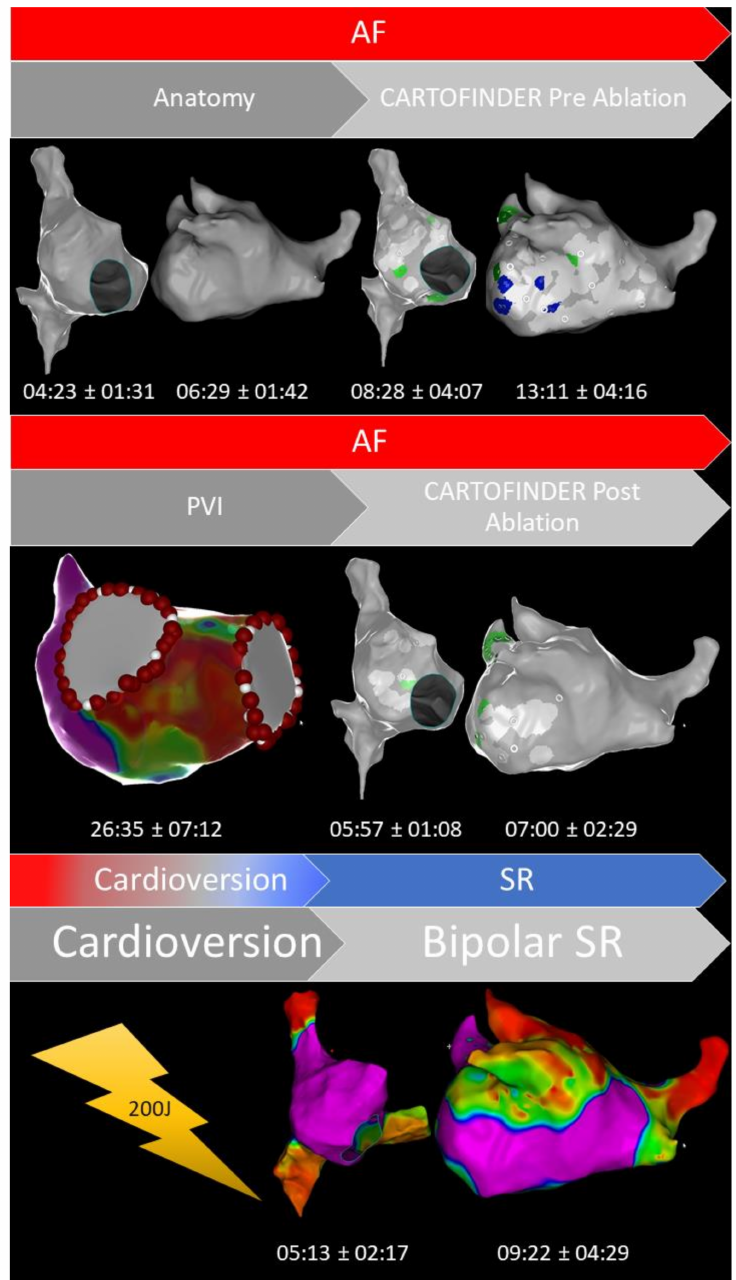
Figure 1. Representative example of our CARTOFINDER workflow (focal activity, green color; rotational activity, blue color) in patients with persistent atrial fibrillation (AF, atrial fibrillation; PVI, pulmonary vein isolation; SR, sinus rhythm). The mean time for each workflow-step is visualized in minutes ± standard